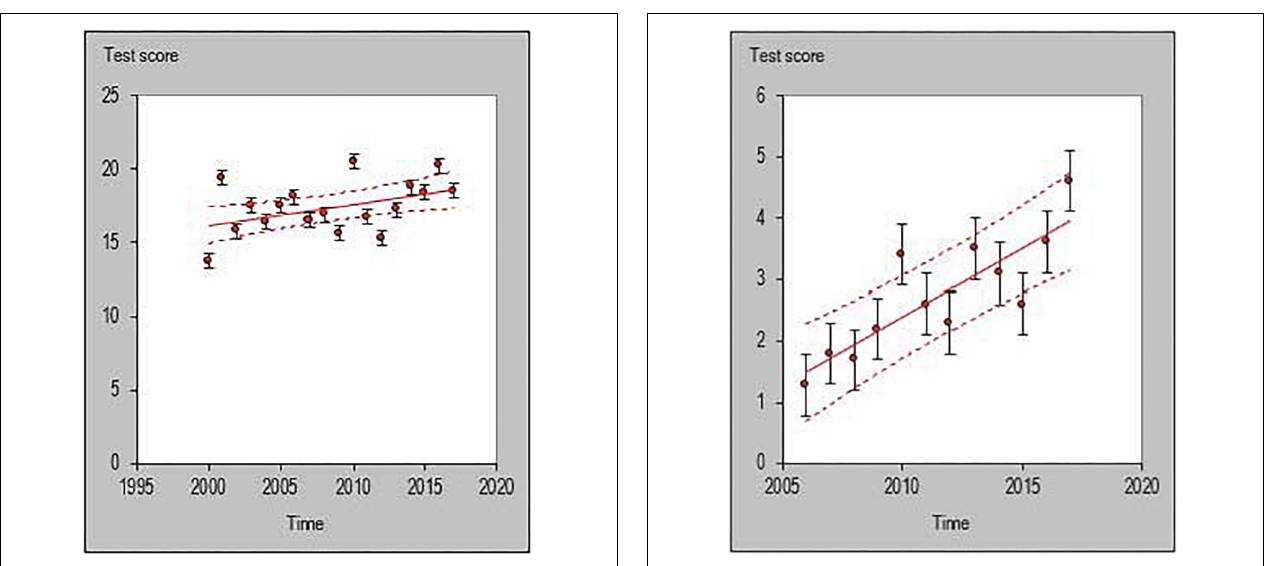
FIGURE 3 | Individual trend of one participant for average assists per season normalized by minute.